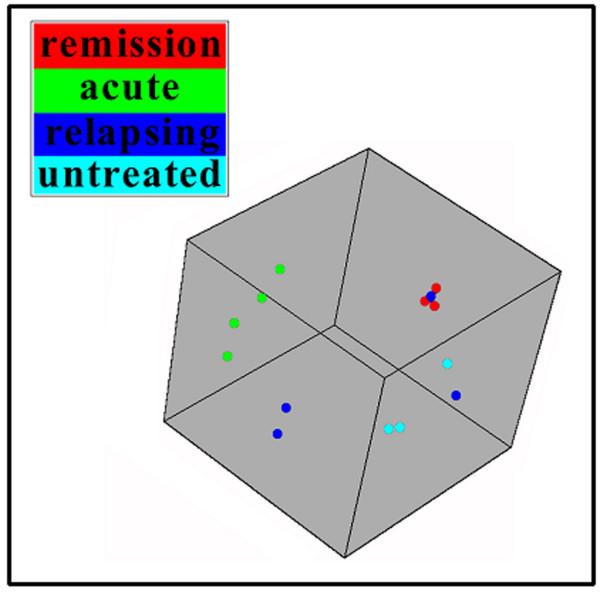
Principal component analysis of the RG U34A hybridizations performed with BRB Array Tools. Hybridization patterns from healthy rats and from rats in the acute and the recovery phase form clusters. This is not the case for hybridization patterns from rats in the relapsing phase.